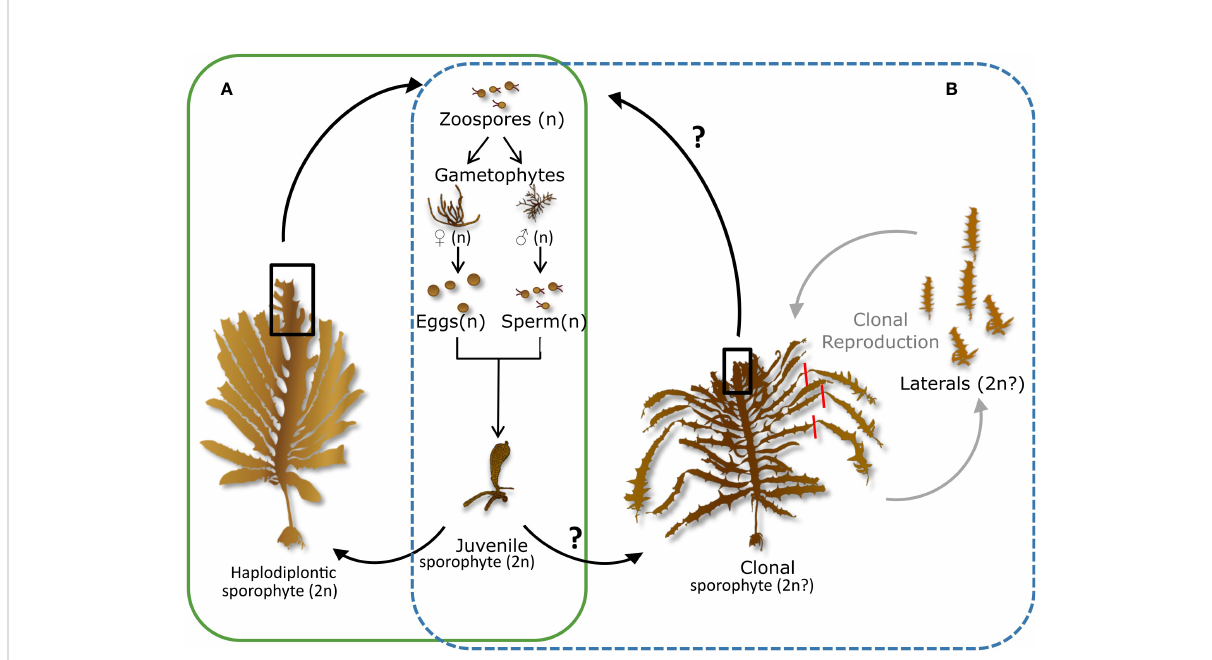
FIGURE 1 Life cycle of Ecklonia radiata. (A) normal sexual haplodiplontic life cycle. The macroscopic sporophyte (2n) produces zoospores (n) through meiosis that develop into male and female gametophytes (n). Male and female gametophytes produce sperm (n) and eggs (n), respectively. The sperm can fertilise the egg and a zygote will develop into a sporophyte (2n). (B) Life cycle of the unique clonal morphotype observed in Hamelin Bay, Western Australia. Clonal reproduction happens through haptera at the distal end of the laterals that allow attachment to the sea fl oor. When laterals attach to the sea fl oor and tear off the ‘ parent ’ individual, a new sporophyte can be formed via clonal reproduction.